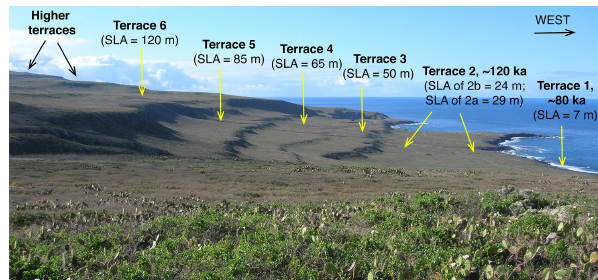
Figure 37. View of the lowest six marine terraces on the west coast of San Clemente Island, California, looking south. Terrace 2b has been dated to MIS 5e ( ∼ 120ka) by TIMS U-series methods on coral (Muhs et al., 2002a); terrace 1 is estimated to be dated to ∼ 80ka (MIS 5a) based on amino acid ratios in mollusks (Muhs, 1983). Terrace 6 could be as old as ∼ 600ka or more, if the rate of uplift has been constant over time. SLA: shoreline angle elevation, in meters above modern sea level. Photograph by Daniel R.